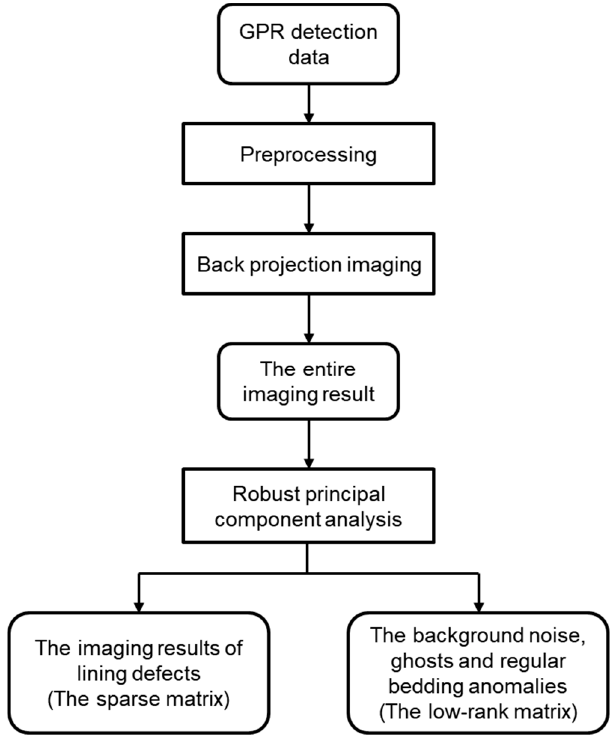
Figure 2. The implementation steps of the integrated